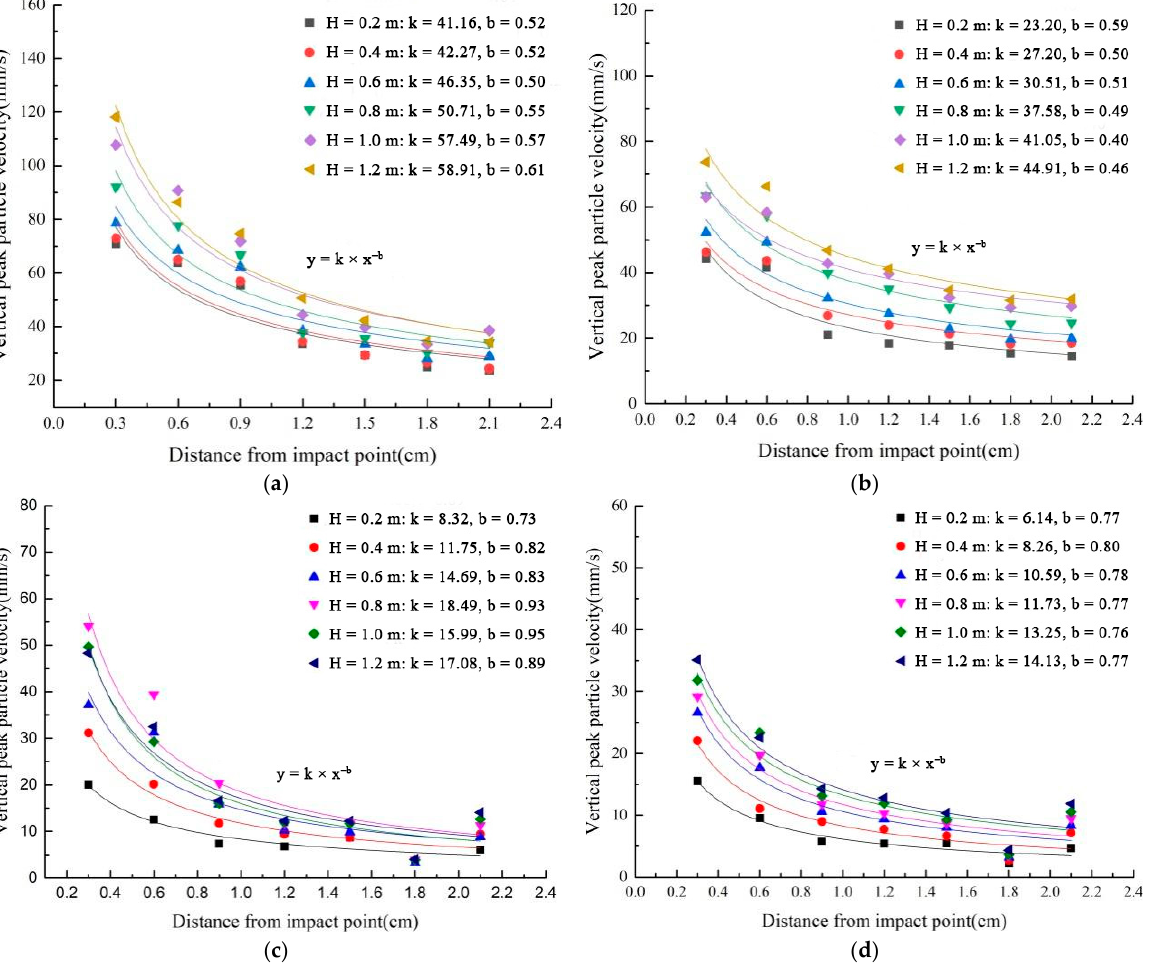
Figure 8. The attenuation law of the vertical peak particle velocity of different thicknesses of concrete slabs: ( a ) 5 cm; ( b ) 10 cm; ( c ) 15 cm; ( d ) 20 cm.